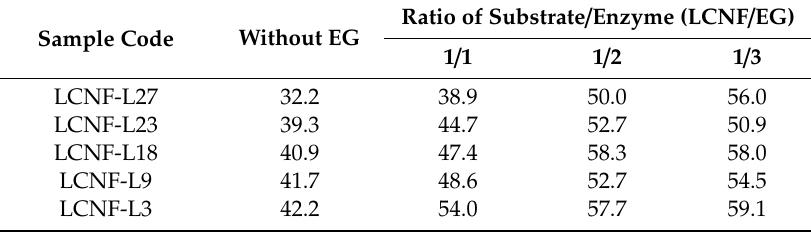
Table 4. Crystallinity index (CrI) of the LCNFs with di ff erent lignin contents after enzymatic treatment using di ff erent EG contents (units: